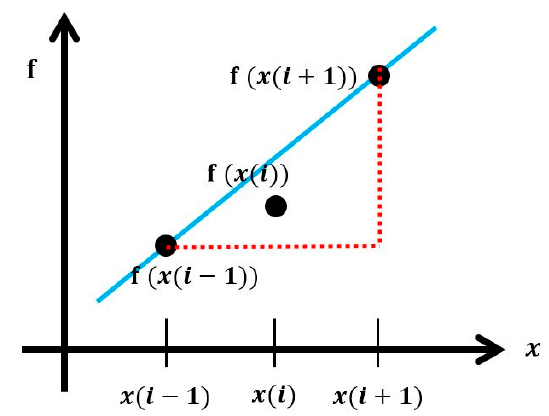
Figure 4. Concept of central difference method.